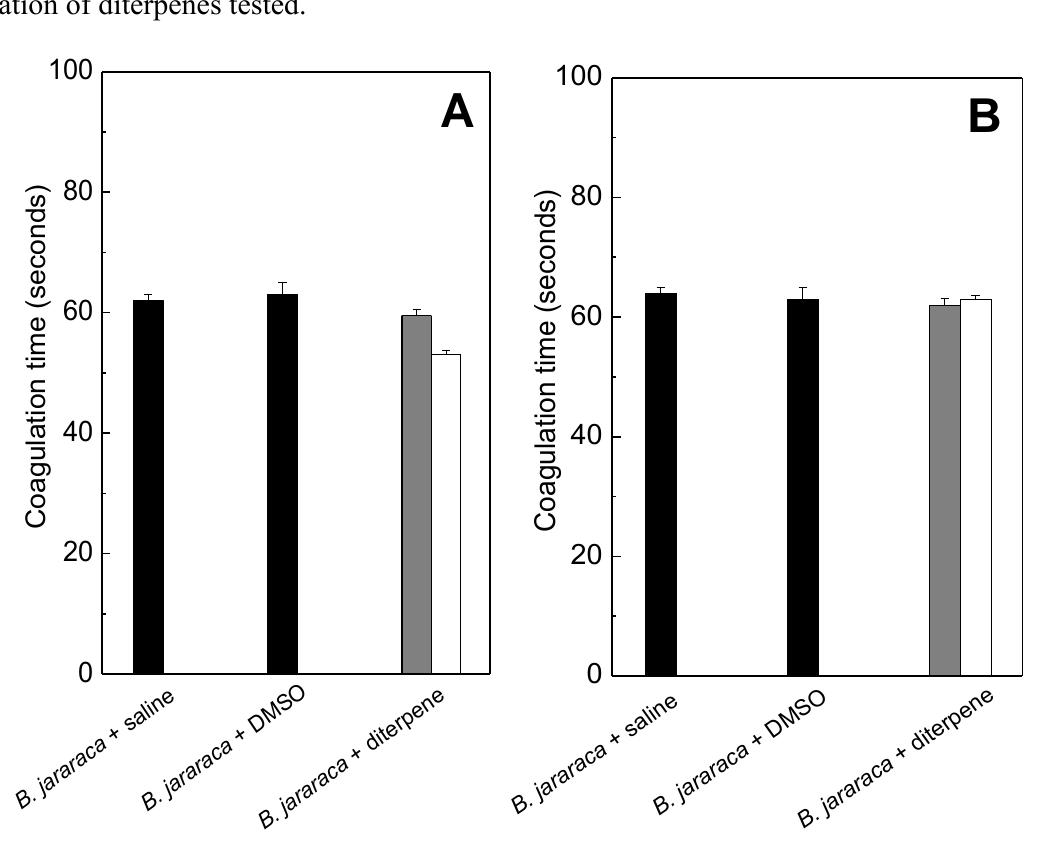
Figure 2. B. jararaca venom (12 µ g/mL) was incubated for 30 min at room